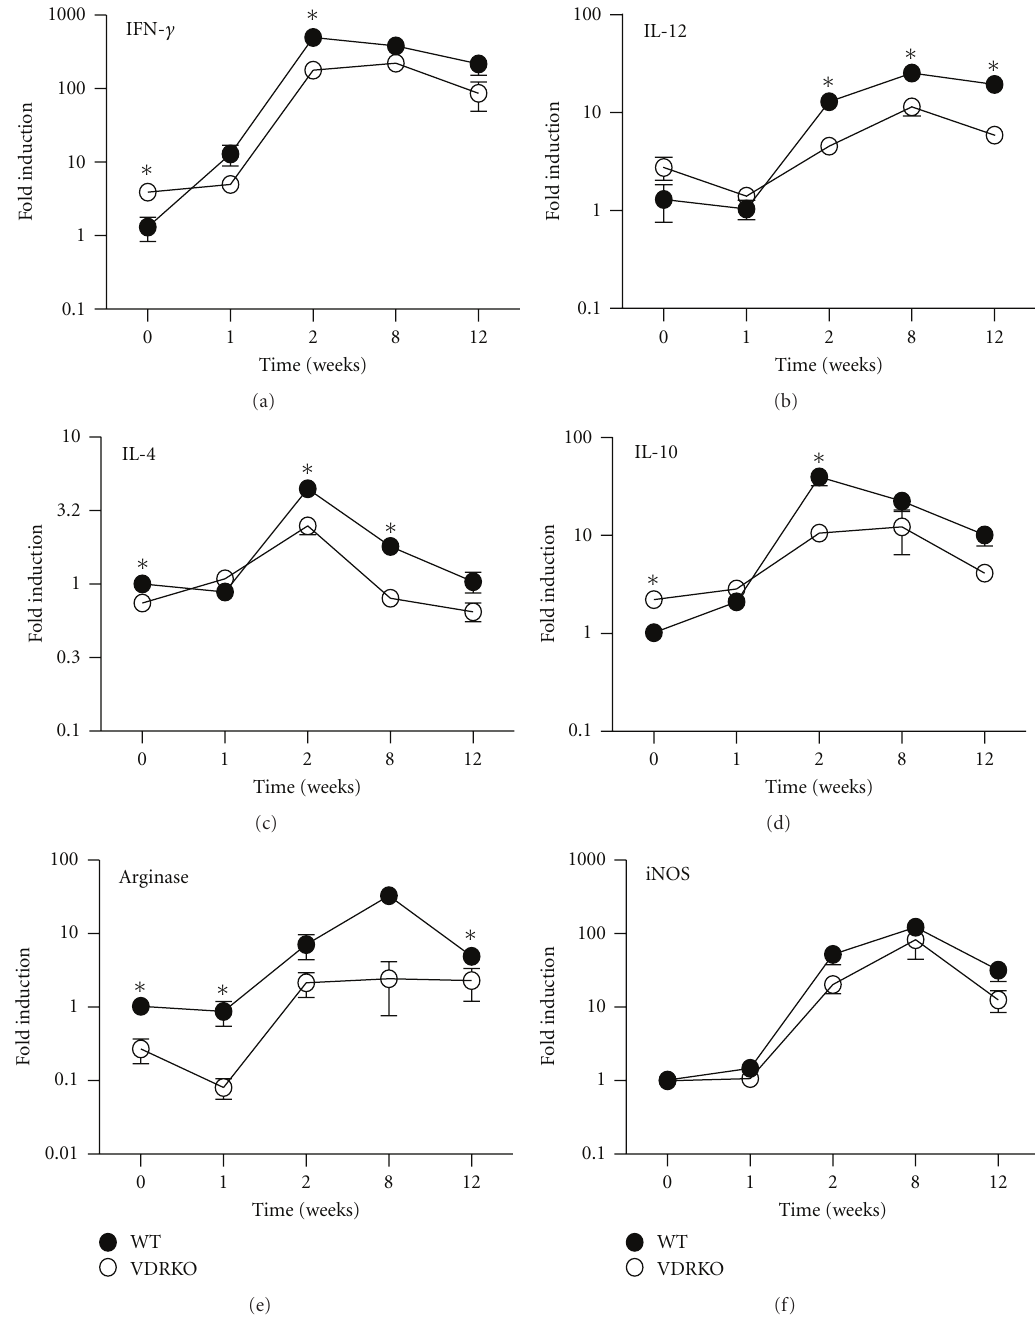
Figure 5: Quantitative RT-PCR analysis of cytokine production at the site of infection. C57BL/6 WT (closed circles) and VDRKO (open circles) mice were infected with 10 5 L. major parasites and their ears were harvested at the indicated time points. Quantitative RT-PCR was performed to determine the fold increase over uninfected WT ears for each cytokine. One representative of two independent experiments is presented. ∗ P ≤ 0 . 05. n = 4 mice/time